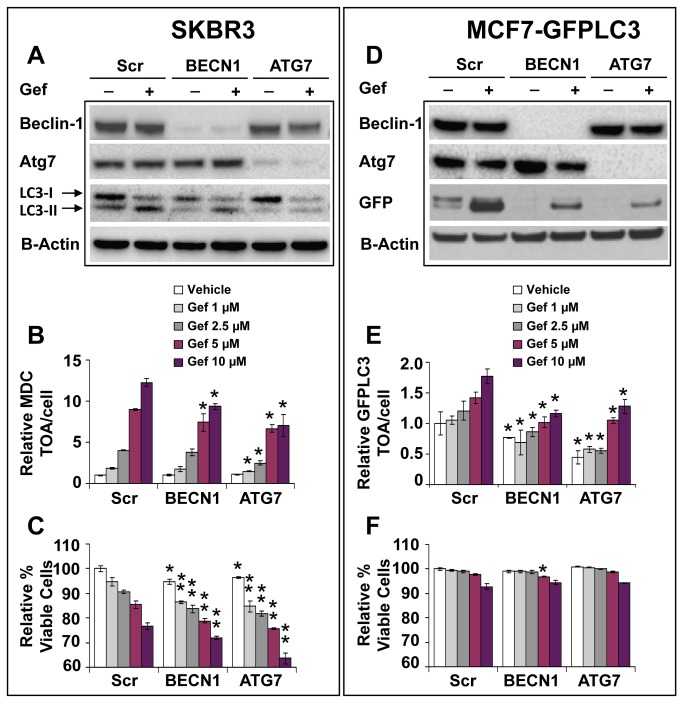
Effects of BECN1 or ATG7 knockdown on autophagy and viability in SKBR3 and MCF7-GFPLC3 cells.Following a knockdown with the indicated siRNA, cells were treated with vehicle or gefitinib (Gef) for 72 h. (A and D) Validation of BECN1 and ATG7 knockdown at the protein levels and analysis of LC3 and cleaved GFP by Western blotting. HCA analysis of TOA (B and E) and viability (C and F) in SKBR3 and MCF7-GFPLC3 cells following BECN1 or ATG7 knockdown (mean±SD, n = 3 wells). The average TOA and % viability are normalized to scrambled siRNA pretreated and vehicle-treated cells expressed as 1 or 100%, respectively. Cell viability was calculated as the proportion of viable cells in the total cell population. A single asterisk in (B), (E) and (F) indicates a statistically significant difference (p<0.05) between cells transfected with BECN1 or ATG7 and cells transfected with a scrambled non-silencing siRNA for the corresponding gefitinib concentration. A double asterisk in (C) indicates a statistically significant difference (p<0.05) between cells with knockdown genes and cells transfected with a scrambled non-silencing siRNA for a corresponding gefitinib concentration in addition to a statistically significant difference when compared to the vehicle-treated cells within each indicated knockdown.